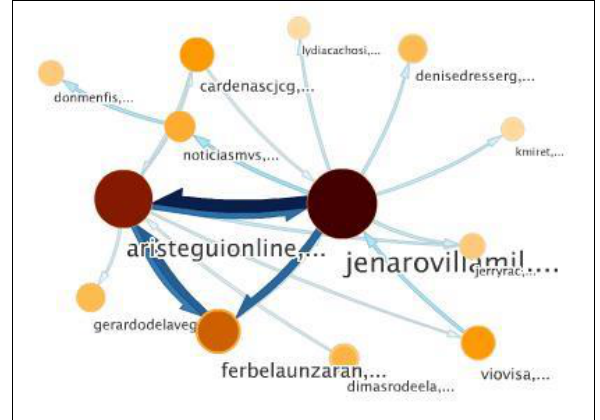
Figure 5. Community detection of the original